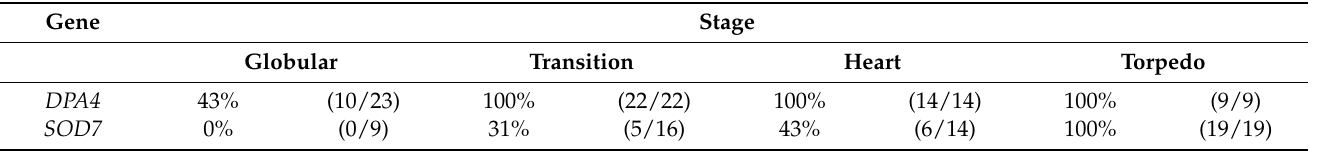
Table 3. Frequency of DPA4 or SOD7 expression in wild-type embryos depending on the develop- mental stage and the genotype.